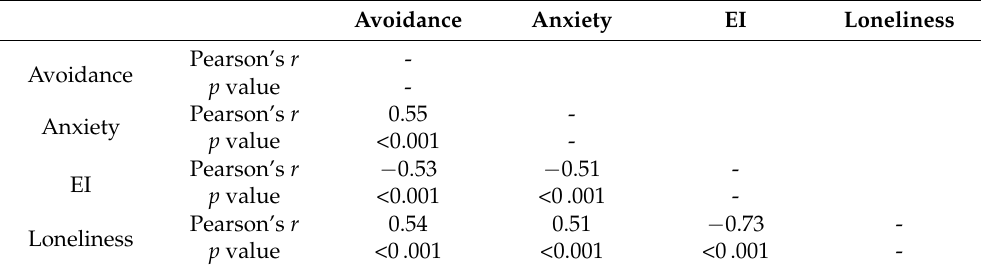
Table 3. Zero-order correlations between the variables (Study 1).